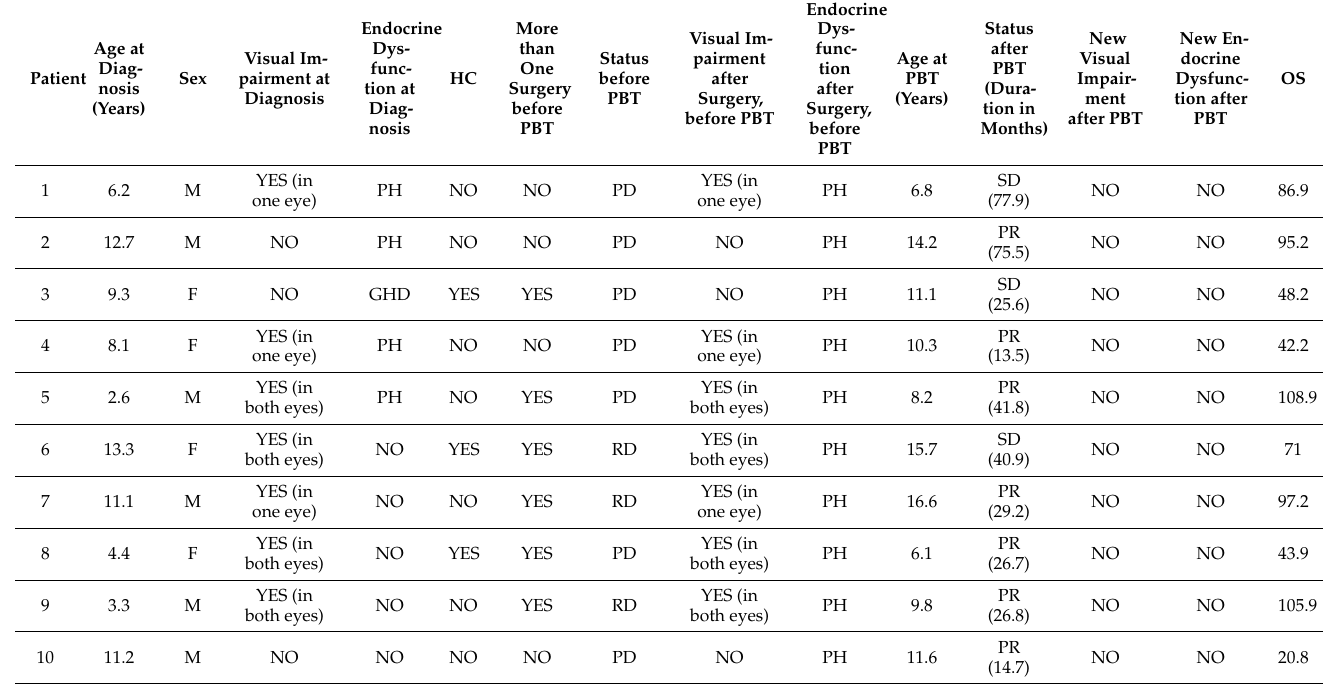
Table 2. Patient characteristics at diagnosis, post-surgery, and